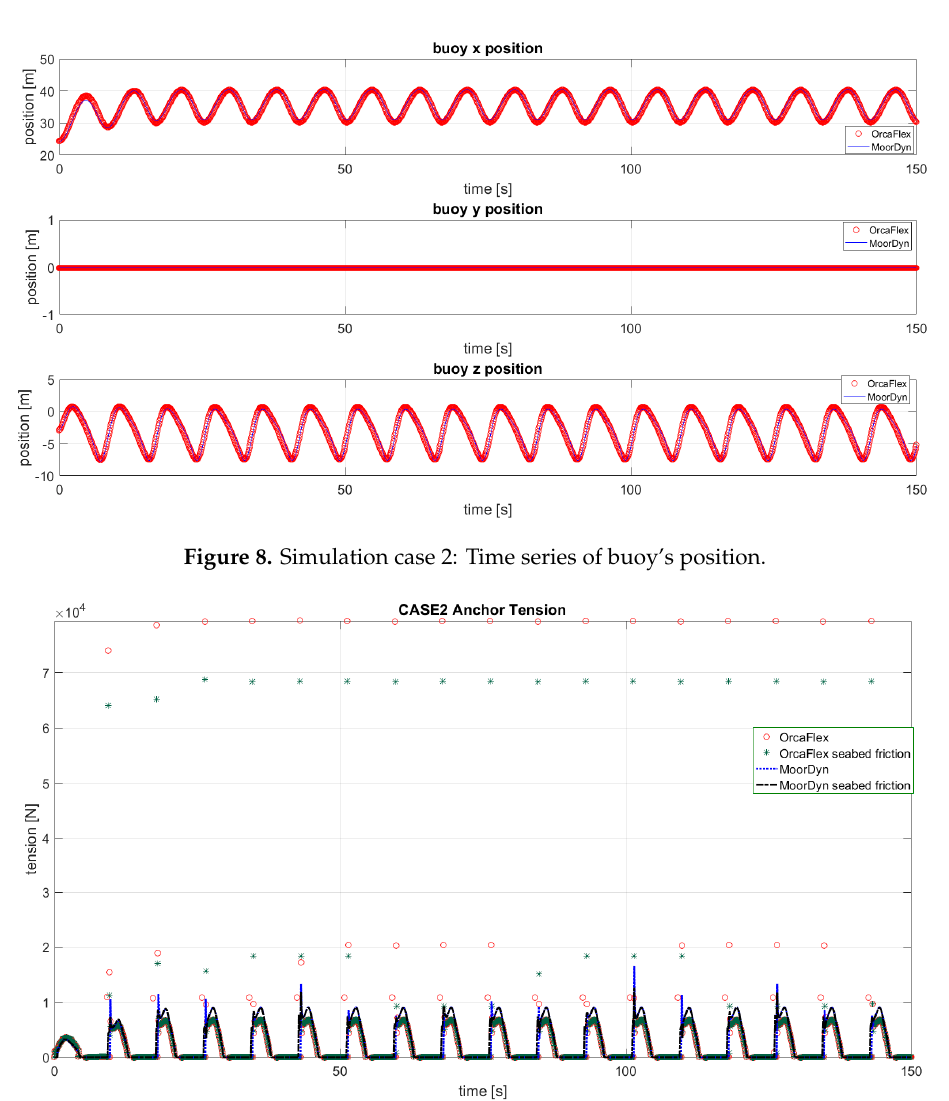
Figure 10. Simulation case 2: Anchor tension comparison at t = 100 s until t = 114 s. 4.3. Simulation Case 3: Irregular wave In simulation case 3, the unidirectional spectrum is used as an input. A list of wave components with different frequencies are generated based on JONSWAP spectrum and used as input for simulation case 3, which can be found in Appendix B. Time series of wave sea elevation at the origin (0, 0) is shown in Figure 11. All the wave components are propagating to the direction of the negative y axis.